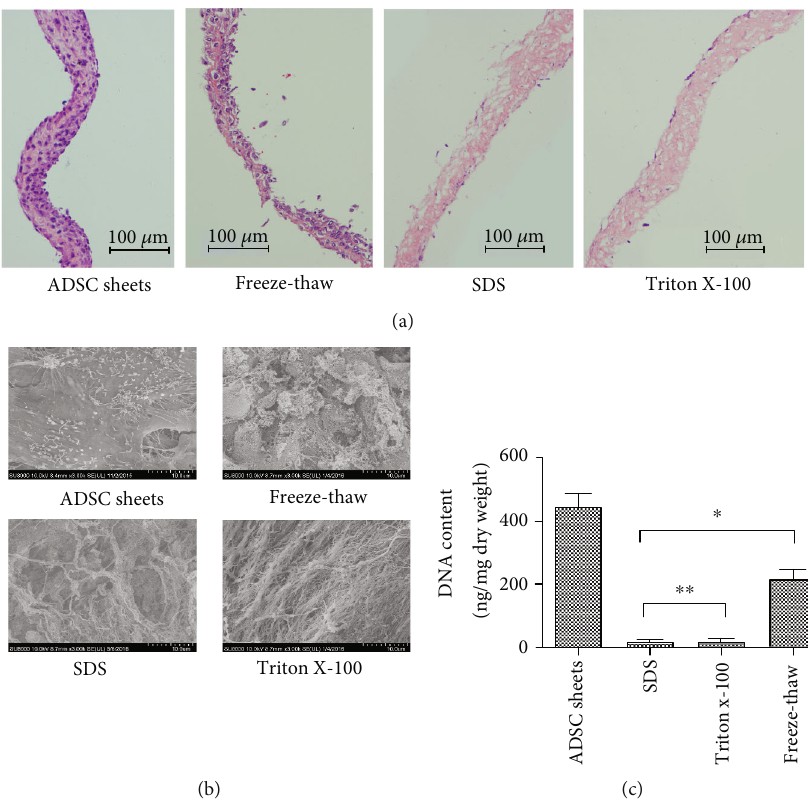
Figure 2: Evaluation of decellularized e ffi ciency with repeated freeze-thaw, Triton X-100, and SDS decellularization. (a) H&E staining after the decellularization treatment. Compared with freeze-thaw treatments, SDS and Triton X-100 treatments removed the cellular contents more e ffi ciently. The repeated freeze-thaw method with cell components residual, SDS method with disturbed and partial rupture collagen fi ber, and decellularized Triton X-100 sample with an intact preserved collagen fi ber structure. (b) Microstructural observations by scanning electron microscopy. (c) DNA quanti fi cation of di ff erent groups. Compared with the repeated freeze-thaw method, the methods of Triton X-100 and SDS more e ff ectively reduced the DNA content ( ∗ P < 0 : 05 ), but no statistically signi fi cant di ff erences were found between these two groups ( ∗∗ P > 0 : 05